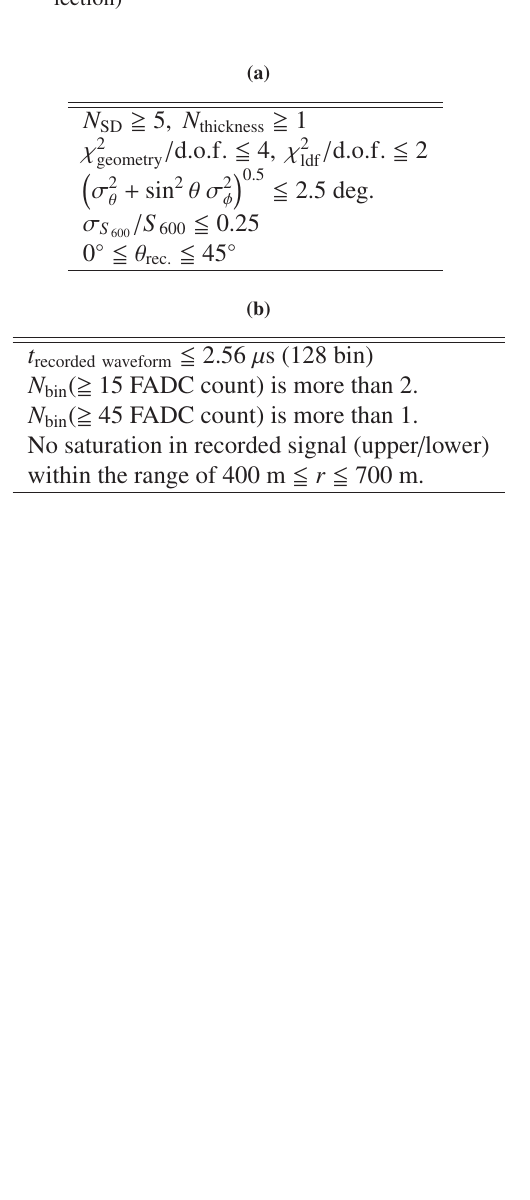
Table 2: (a)Event selection criteria (b) N thickness selection (SD se-